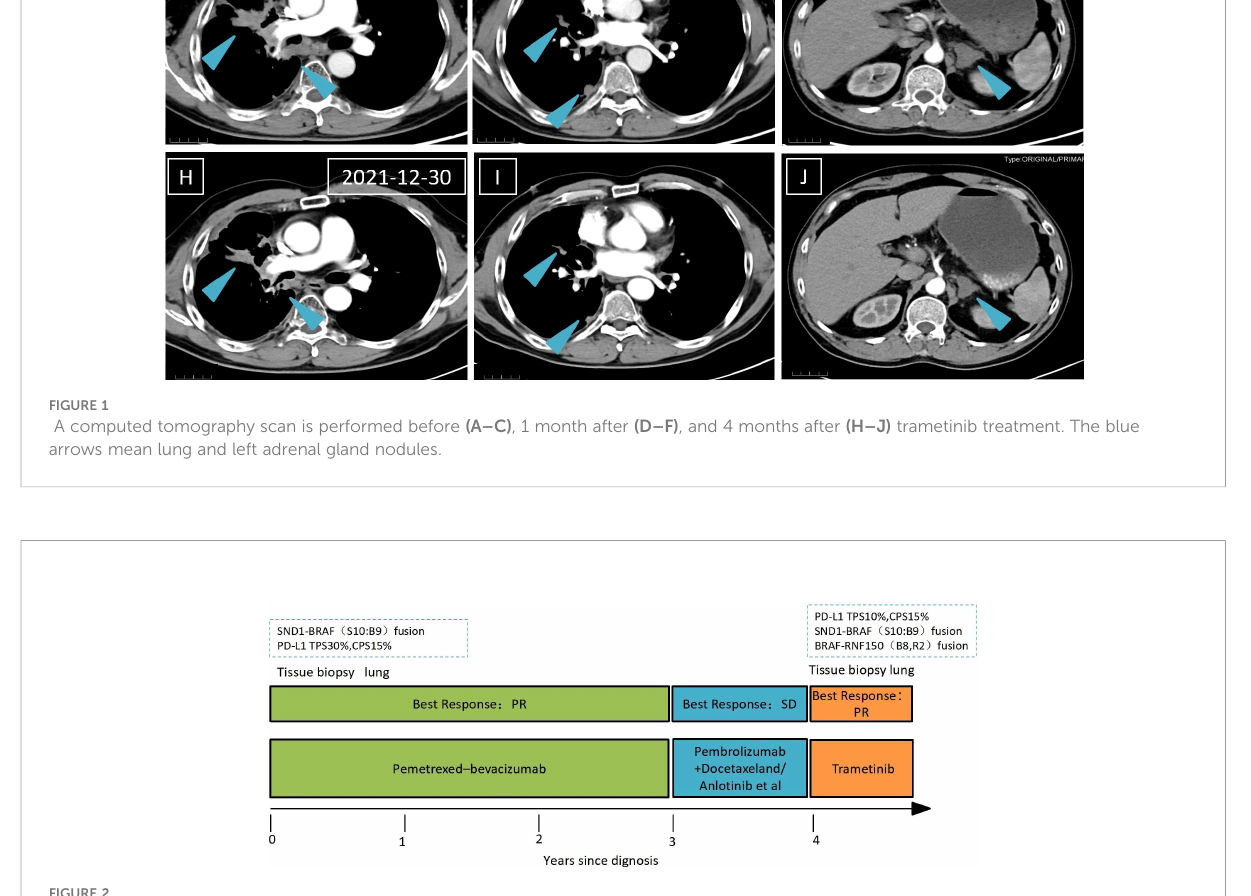
FIGURE 2 Timeline and duration of each